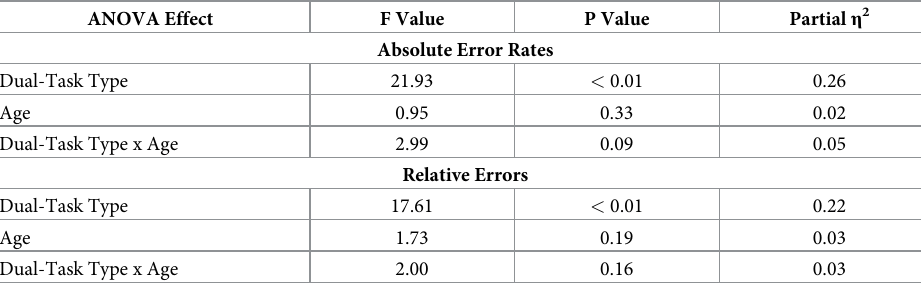
Note: Older (N = 32) and Younger (N =